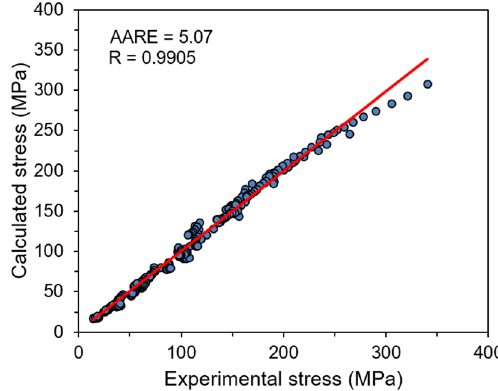
Figure 7. The correlation between calculated and experimental flow stresses for Ti-1023 alloy.